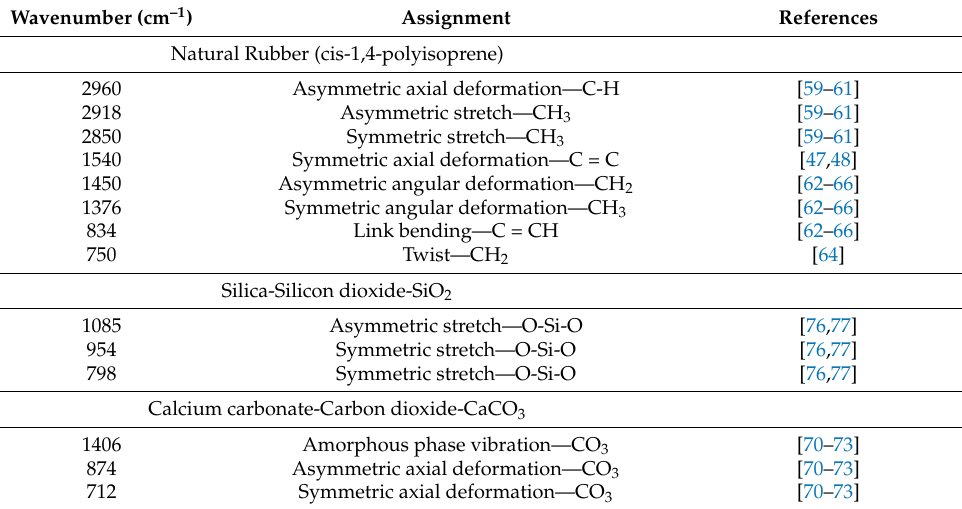
Table 5. Main peaks of the natural rubber composite (gum) and the pure fillers (silica and calcium carbonate) found by FTIR in ATR mode (4 cm − 1 spectral resolution, DTGS detector using 32 scans, and analyzed over a zinc selenide, ZnSe,